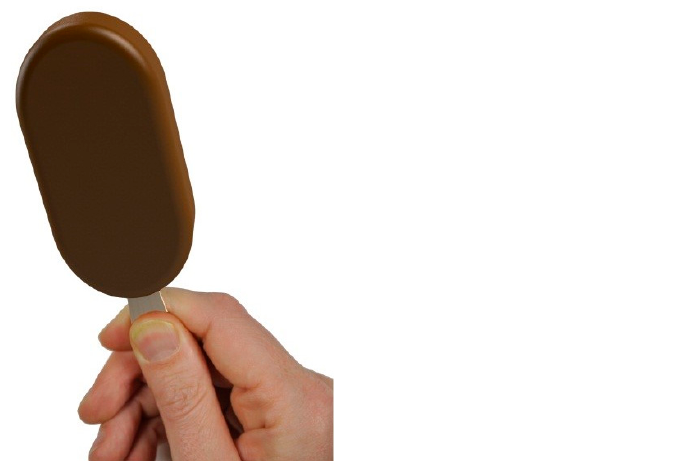
Figure 1. Example of picture used in the adjustment task with ice cream stick displayed on a computer screen in ¾ frontal view.